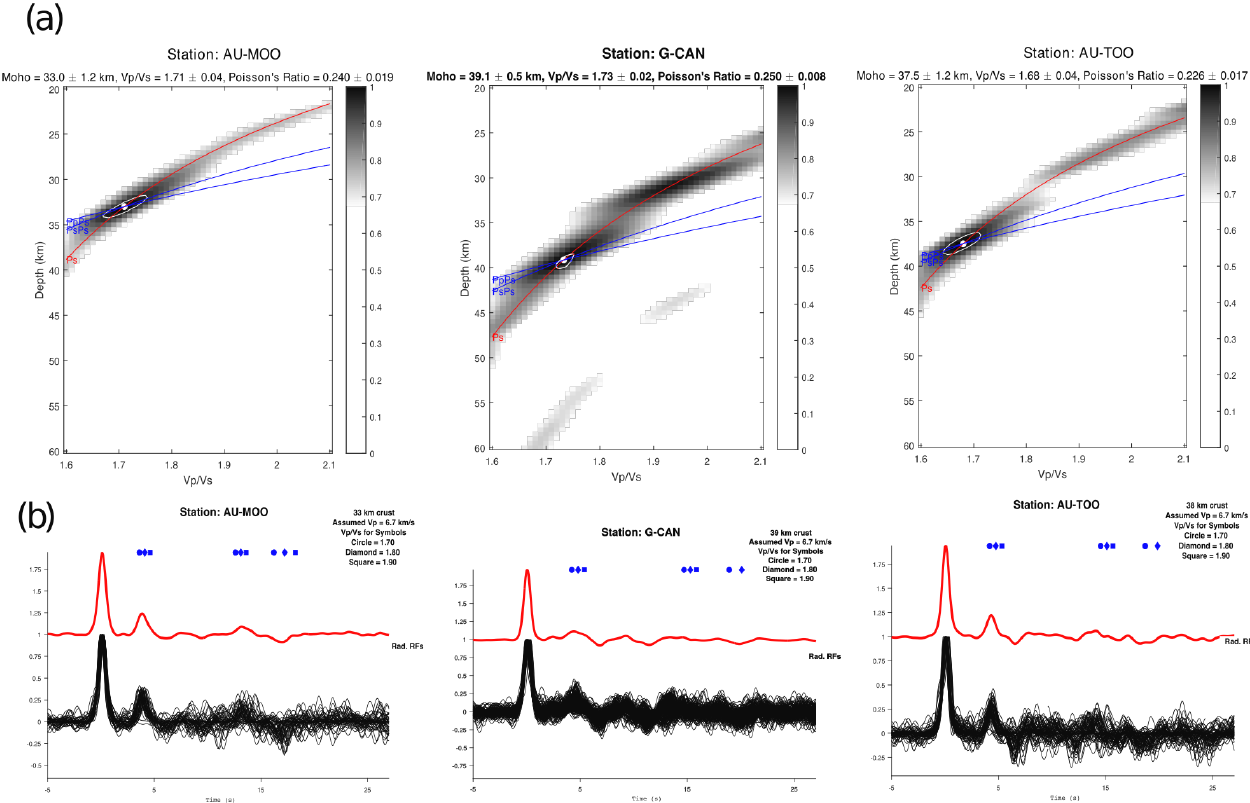
Figure 5. Results from the H – κ stacking analysis for RFs (Zhu and Kanamori, 2000) at MOO, CAN, and TOO stations. (a) Normalized amplitudes of the stack over all back-azimuths along the travel time curves corresponding to the Ps and PpPs phases for each case. (b) The corresponding stacked receiver function for each station. Table 1. Model parameter bounds used in the neighbourhood algorithm receiver function inversion. V upper s and V lower s represent the S - wave velocity at the top and bottom of a layer respectively. V p /V s represents the P - and S -wave velocity ratio within a layer. Layer Thickness (m) V upper s (km/s) V lower s (km/s) V p /V